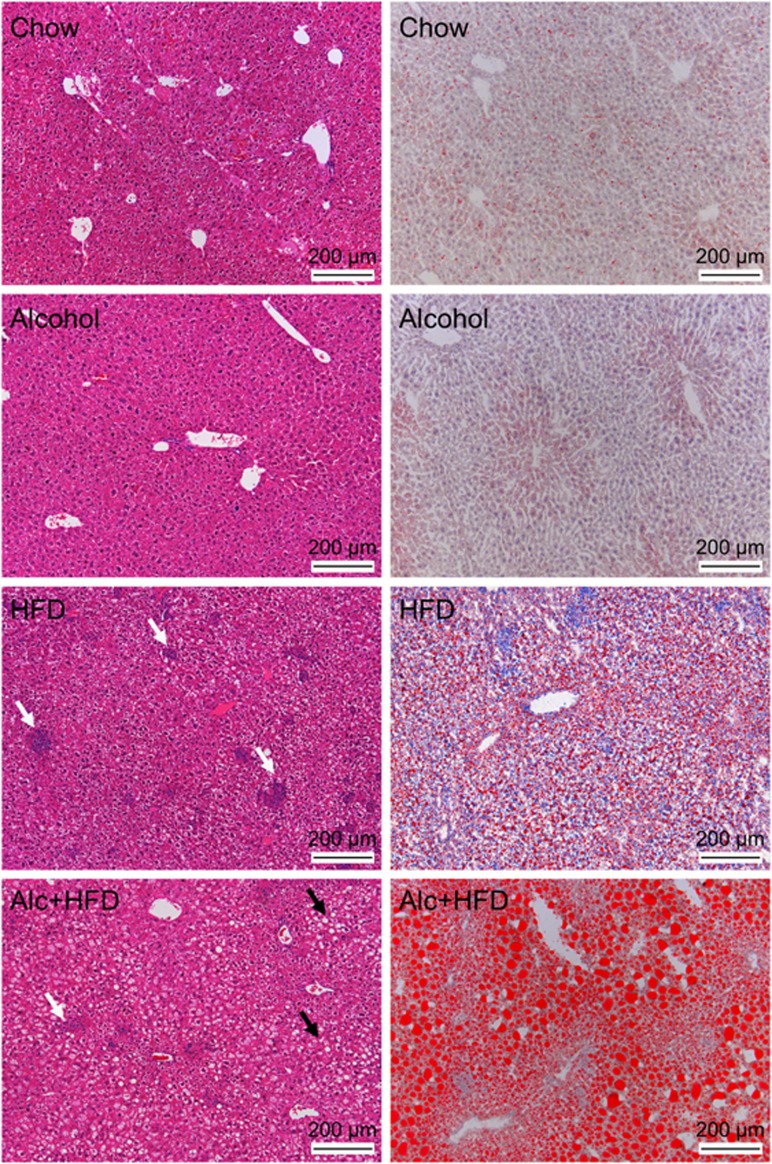
Alcohol and HFD increase lipid accumulation and cellular infiltration in mouse livers. Left panel-H&E staining: Maximum steatosis (black arrows) was observed in livers of Alc+HFD-treated mice and HFD-treated mice showed increased inflammatory cell clusters (white arrows) compared with control liver. Right panel-ORO staining: Maximum lipid accumulation (red) was observed in Alc+HFD-treated mice followed by HFD treatment. Alcohol only minimally increased steatosis. Representative images at × 10 magnification. H&E, haematoxylin and eosin; ORO, Oil Red O.